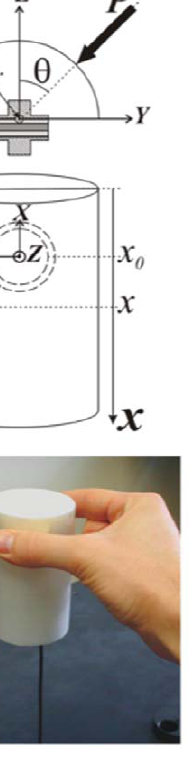
Figure 2. Functioning of the instrumented cylinder. A. The apparatus is designed to measure the orientation ( h ) and vertical location ( x ) of the applied force ( P ) by either the index or thumb while exerting a grip force. These parameters are computed from outputs of a F/T sensor (with axes X , Y and Z ) embedded in the two half-cylinders using two T-adaptors. B . The participants were asked to lift the cylinder with the thumb and index fingers of the right hand and hold it at about 5 cm above the